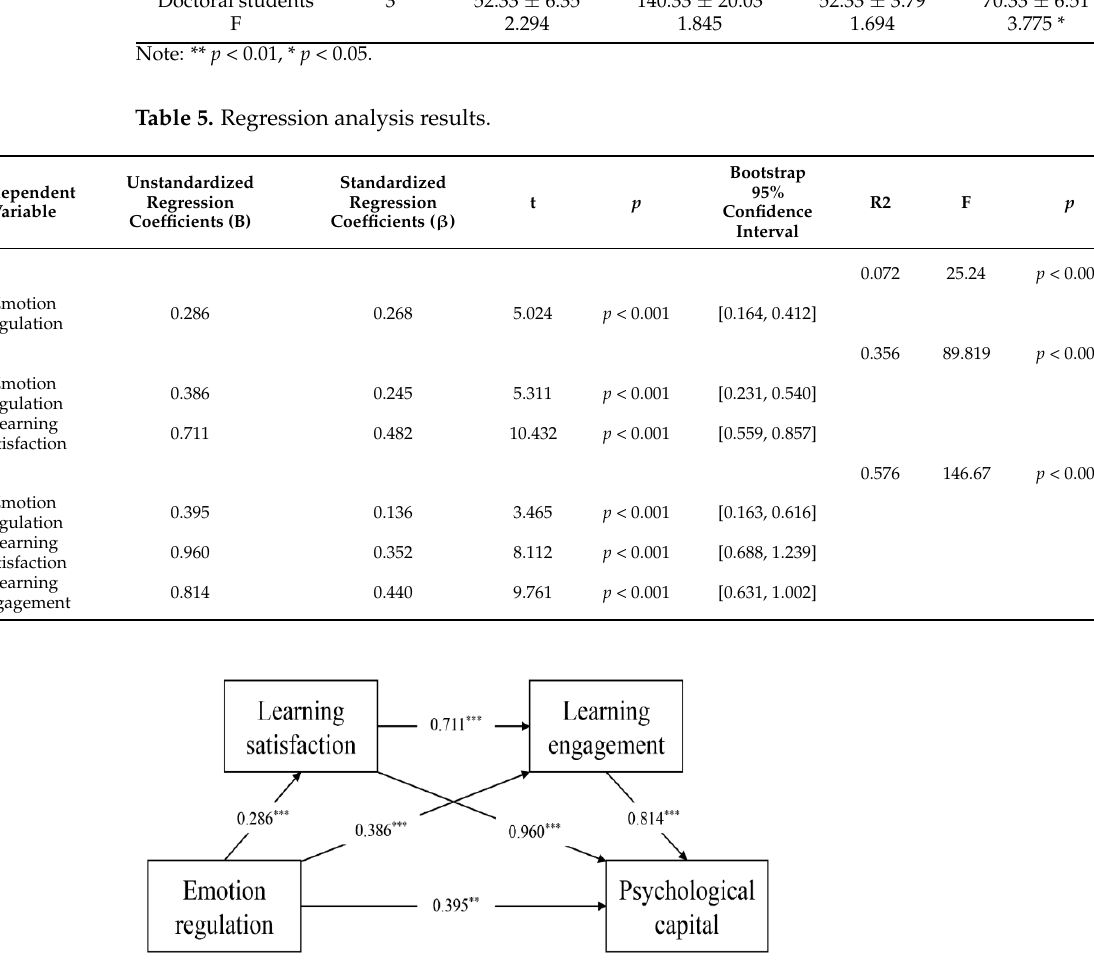
Table 5. Regression analysis results.